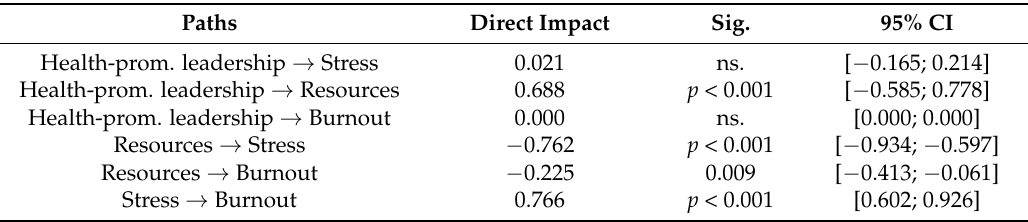
Table 3. Indirect impacts in the structural model—sample 1.